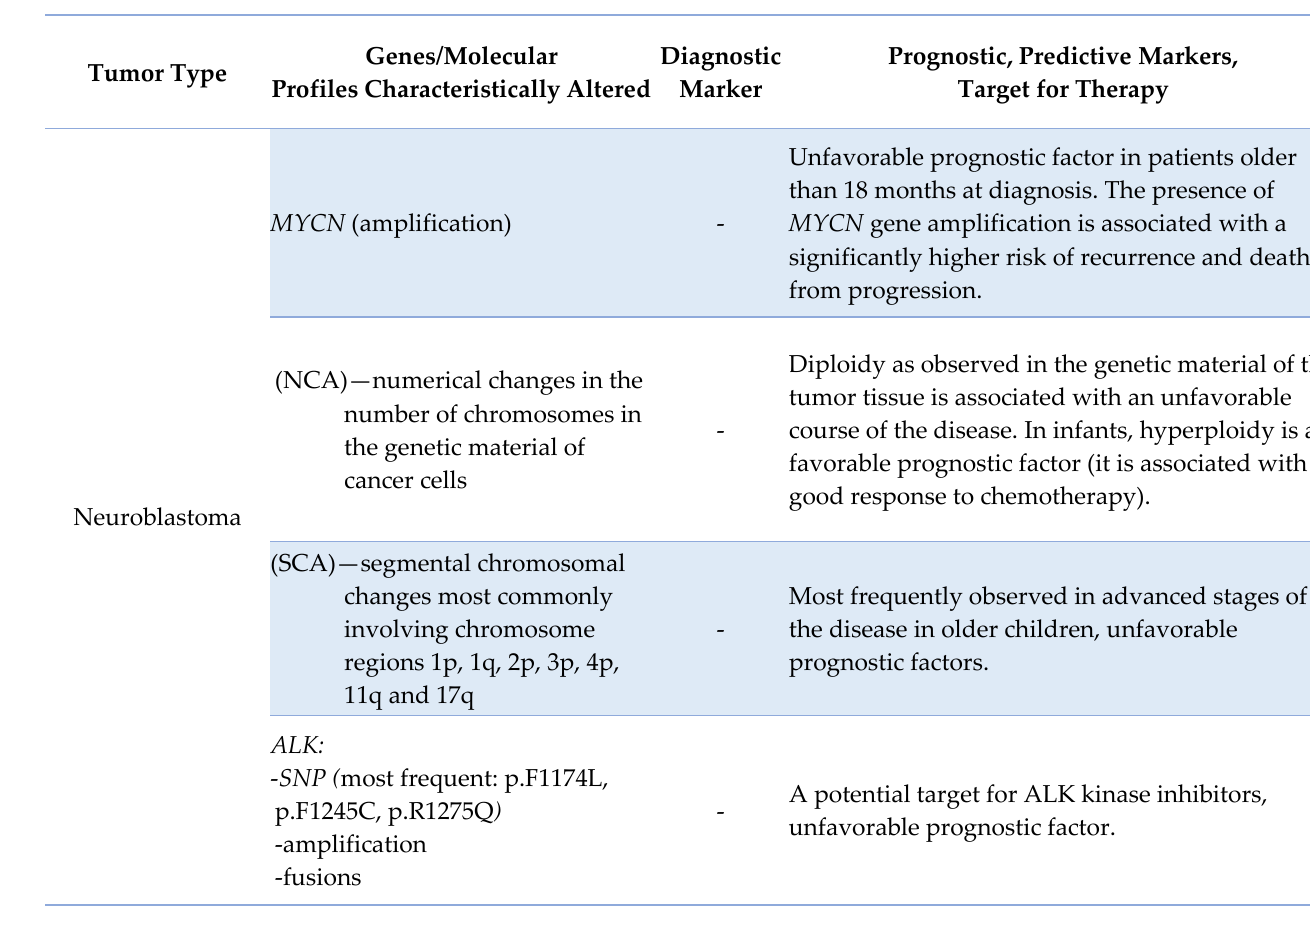
Table 2. Molecular markers—neuroblastoma.